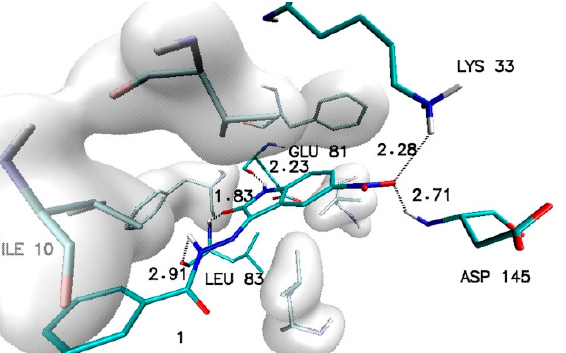
Figure 2. The graphic representation of interactions involved in stabilization of CDK2 complex with N (cid:48) -[5-nitro-2-oxo-1,2-dihydro-3 H -indol-3-ylidene]benzohydrazide ( 1 ).